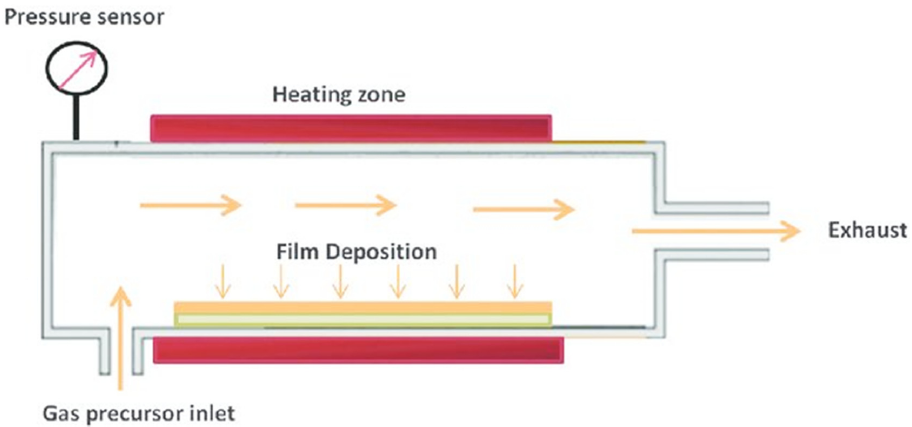
Figure 3. Schematic diagram of a chemical vapor deposition (CVD) system [44].